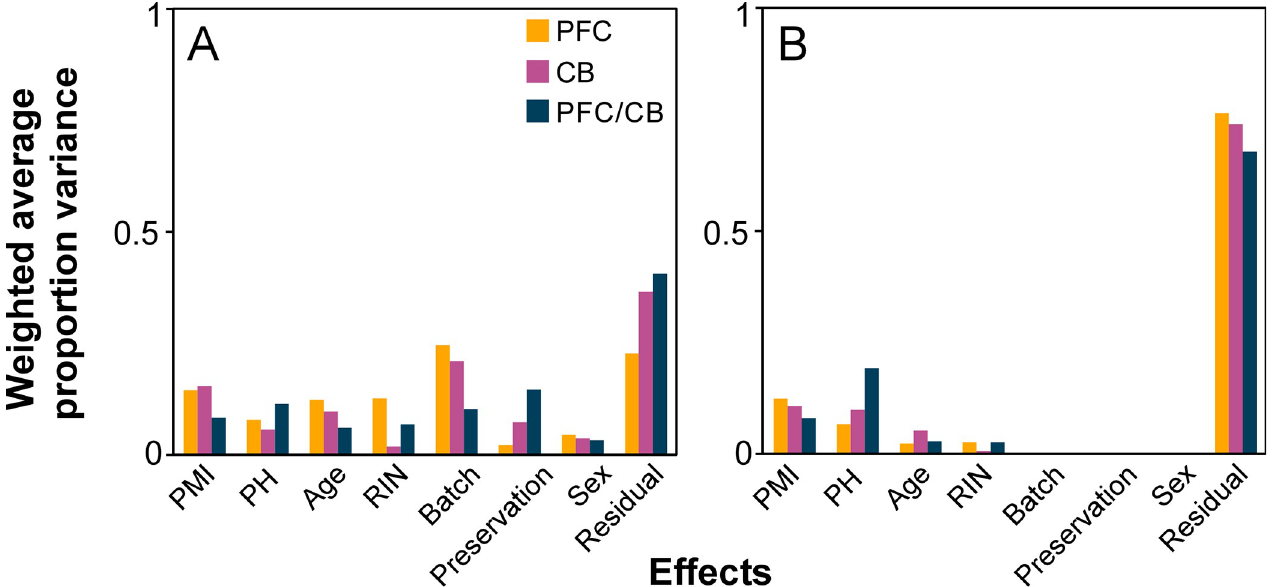
Fig 2. PVCA of array data. Each bar represents the proportion of total variance attributable to its associated factor before ( A ) and after ( B ) linear modeling. Because the ratio groups had pH and RNA-integrity numbers from each tissue, these PVCA calculations included nine covariates whereas PFC-only and CB- only analyses included seven covariates. Although the interregional PFC/CB ratio attenuated the variance owing to covariates, linear modeling was required to minimize their effects.